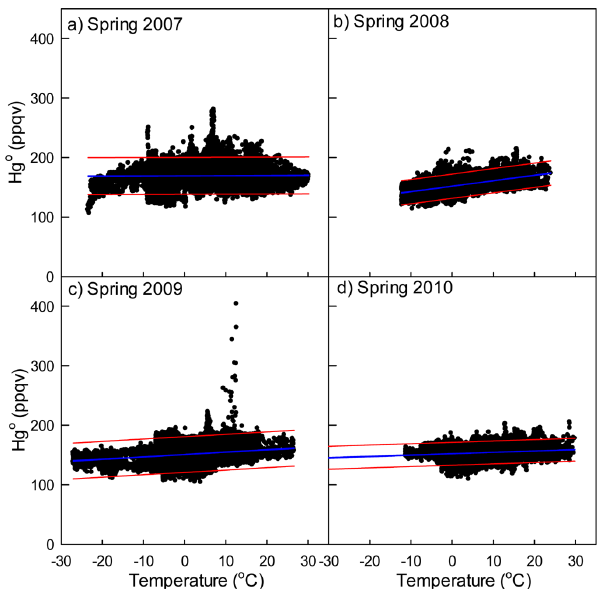
Fig. 8. Mixing ratios of Hg 0 versus temperature in springs 2007– 2010 at PM